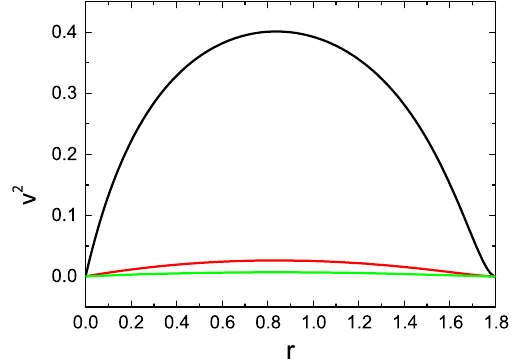
Fig. 4 (Squared) Speed ¯ v 2 (Eq. 46) of a uniformly accelerated particle inside the horizon of the AdS BH for α = 1; 0 . 2; 0 . 1 (black/red/green) ( M = 1, Λ = 0 .